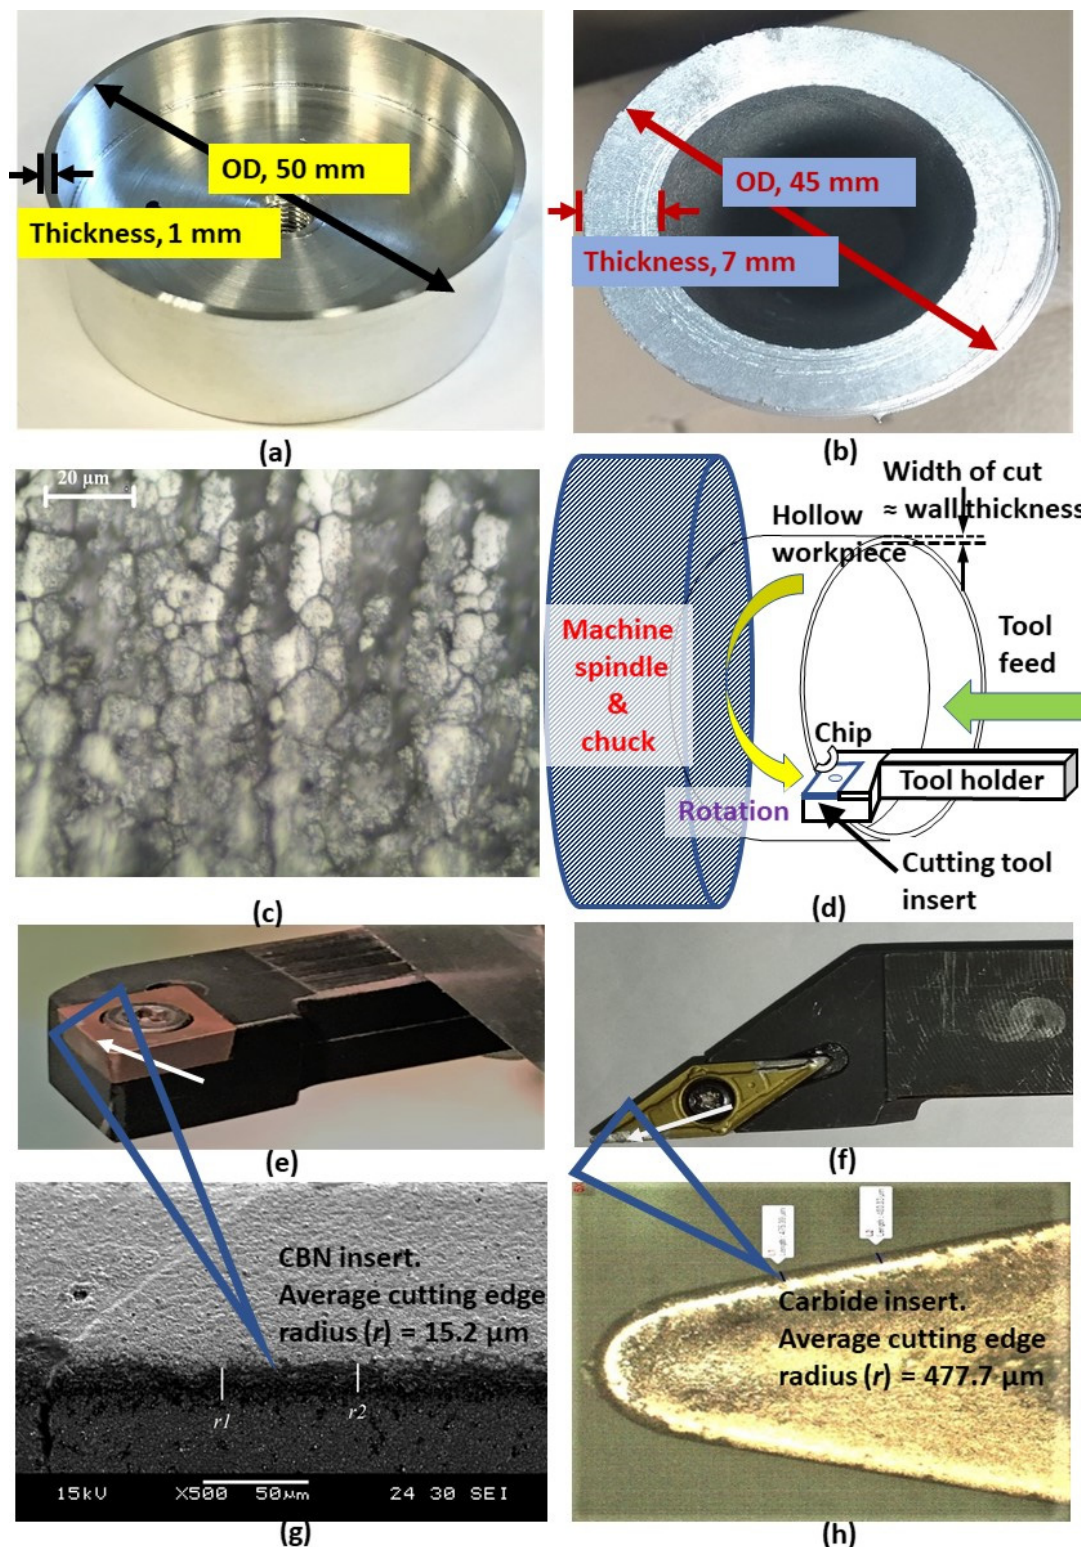
Figure 2. Al alloy workpiece and cutting tool insert used in micromachining in the Toshiba ULG-100C(H 3 ) ultra-precision lathe ( a , e , g ) and macro machining in CS6266B conventional lathe ( b , f , h ) with microstructure ( c ) and cutting scheme ( d ).